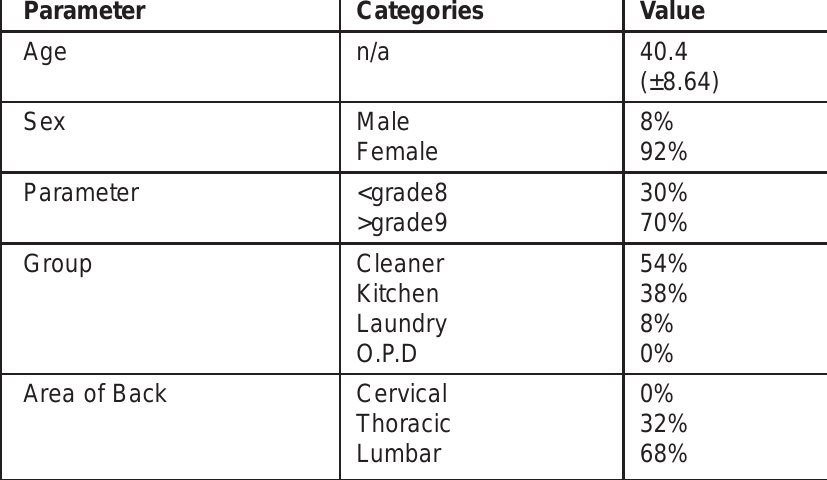
Table 2: Demographic data of subjects. Retest group (n =